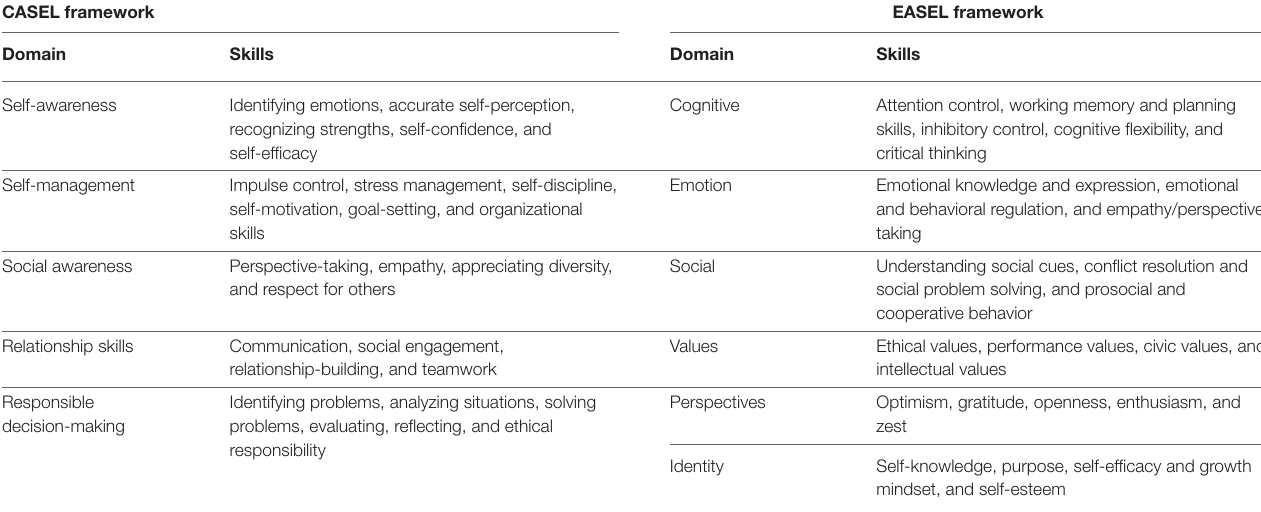
TABLE 12 | CASEL and EASEL